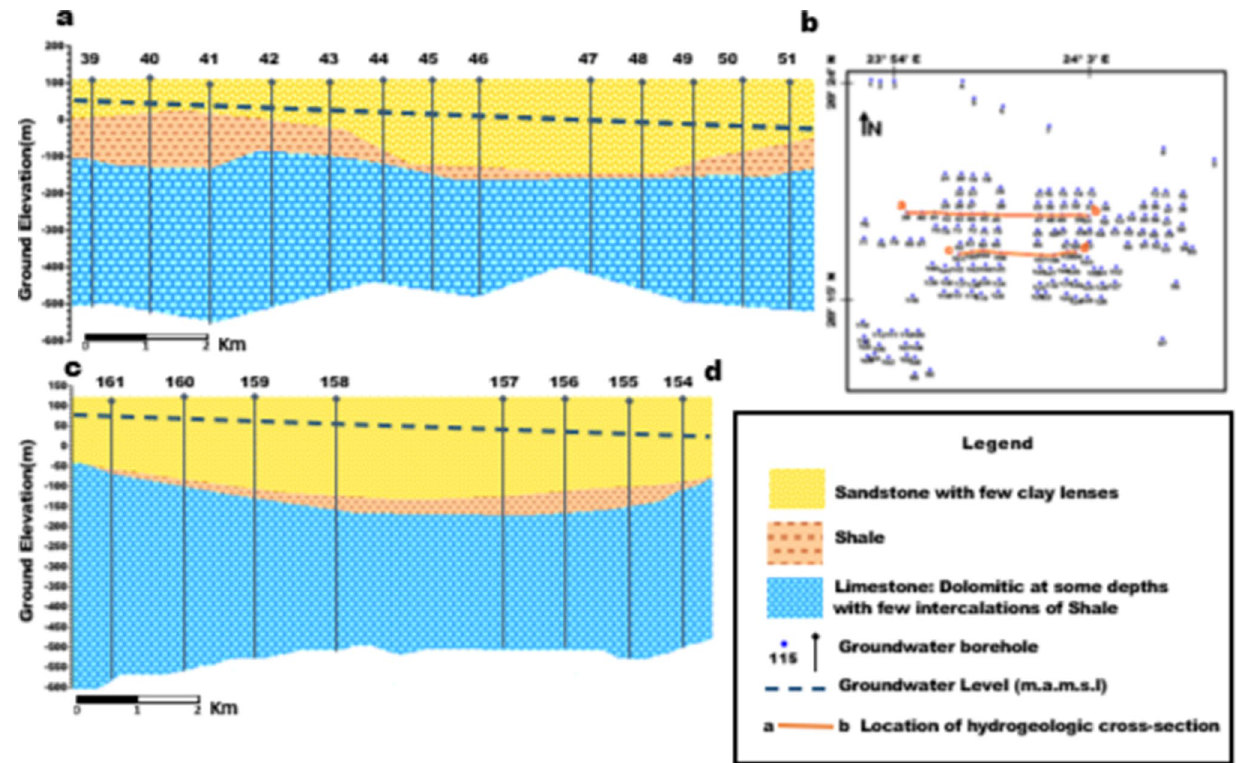
Fig. 5 Hydro-stratigraphic cross sections in the new development